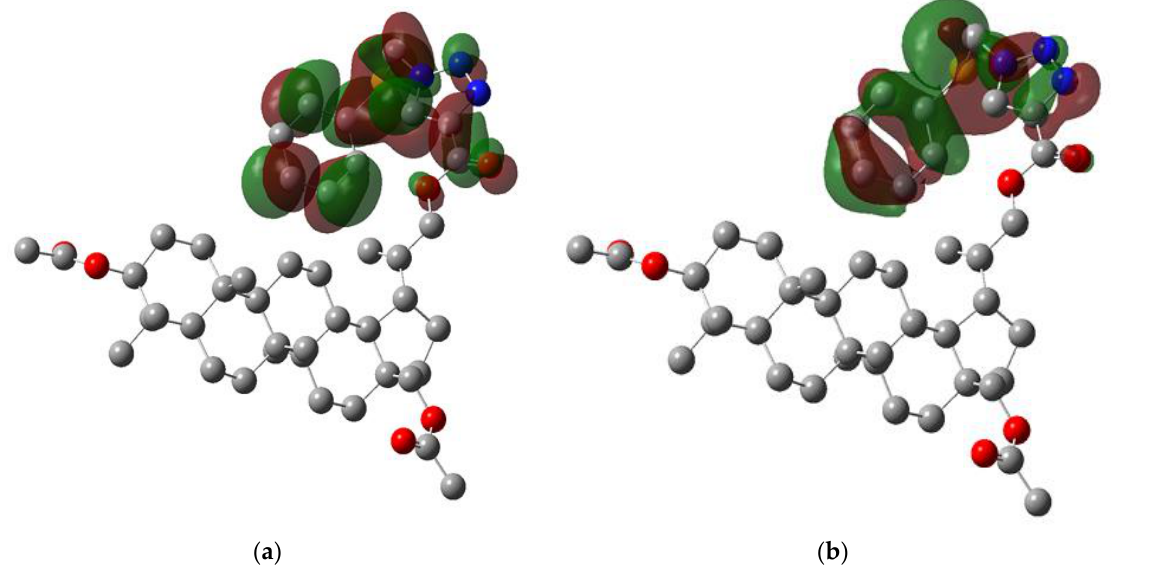
Figure 9. The molecular orbitals of 4 : ( a ) LUMO; ( b ) HOMO. Energies of the HOMO and LUMO orbitals were used to calculate the global reactivity descriptors such as ionization potential (I), electron affinity (A), hardness (η), softness (s), chemical potential (µ), electronegativity (χ), and electrophilicity index (ω) [34]. The obtained values are presented in Table 4. Table 4. Calculated molecular properties of 4